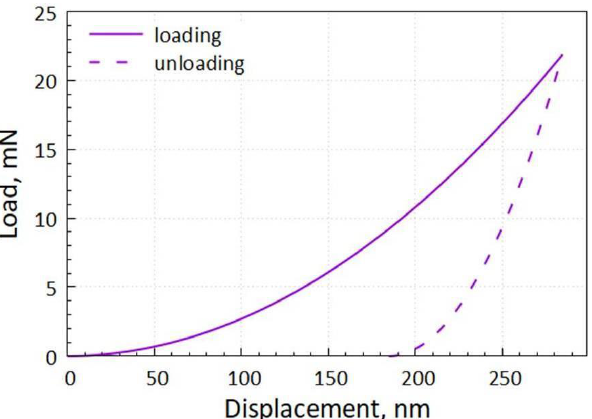
Figure 7. Load – displacement curve of specimen deposited with NiB-Cr 7 C 3 coating.